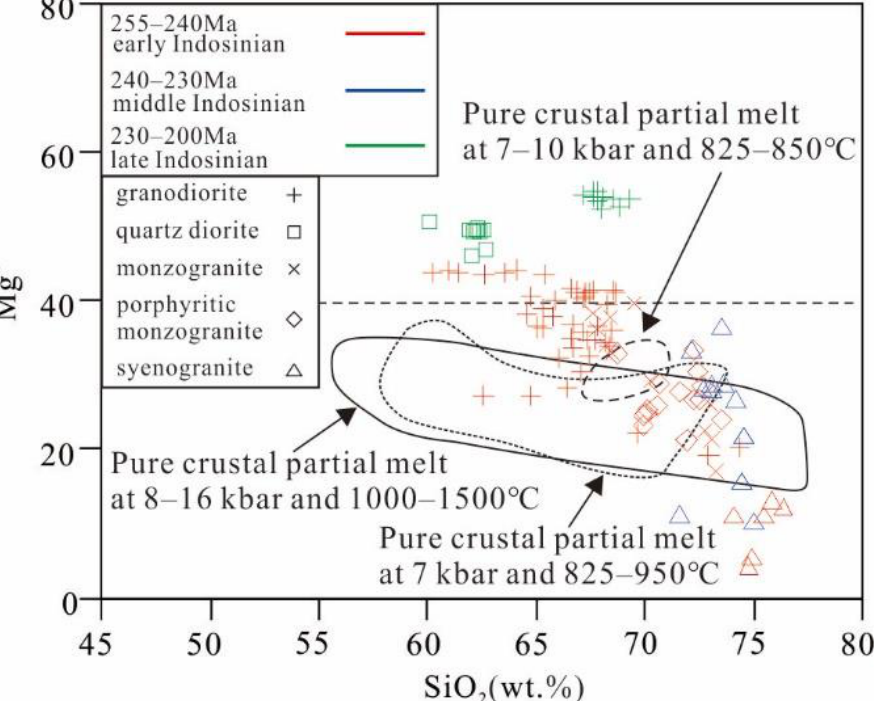
Figure 9. Diagrams of Mg # vs. SiO 2 for the Indosinian granite plutons in the eastern region of the EKO. The results of the published work shown in the figure include the fields of pure crustal partial melts determined in experimental studies for dehydration melting of a two–mica schist at 7–10 kbar and temperatures of 825–850 ◦ C [78]; the dehydration melting of low–K basaltic rocks at 8–16 kbar and temperatures of 1000–1050 ◦ C [59]; moderately hydrous (1.7–2.3% H 2 O) medium– to